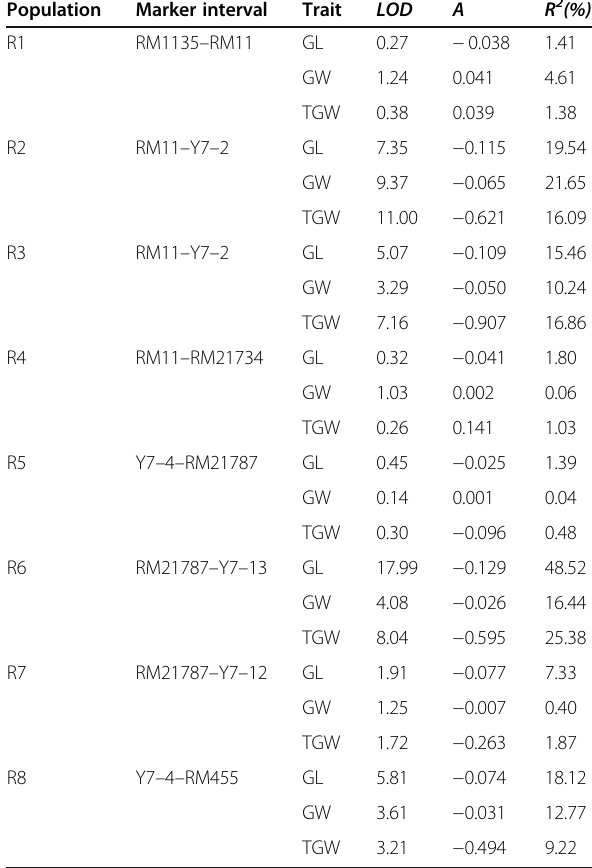
Table 4 QTLs detected for three grain traits in the R1 – R8 populations Population Marker